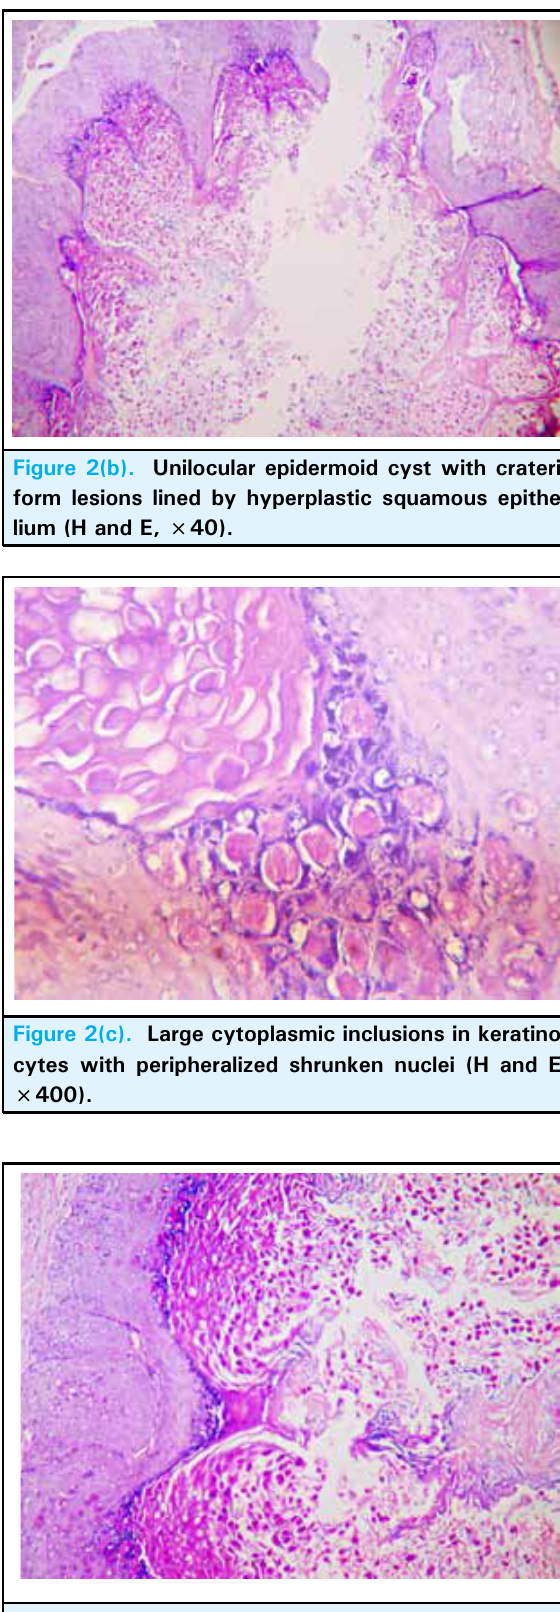
Figure 2(d). Cyst containing plenty of molluscum bod - ies and loose lamellar keratin (H and E,